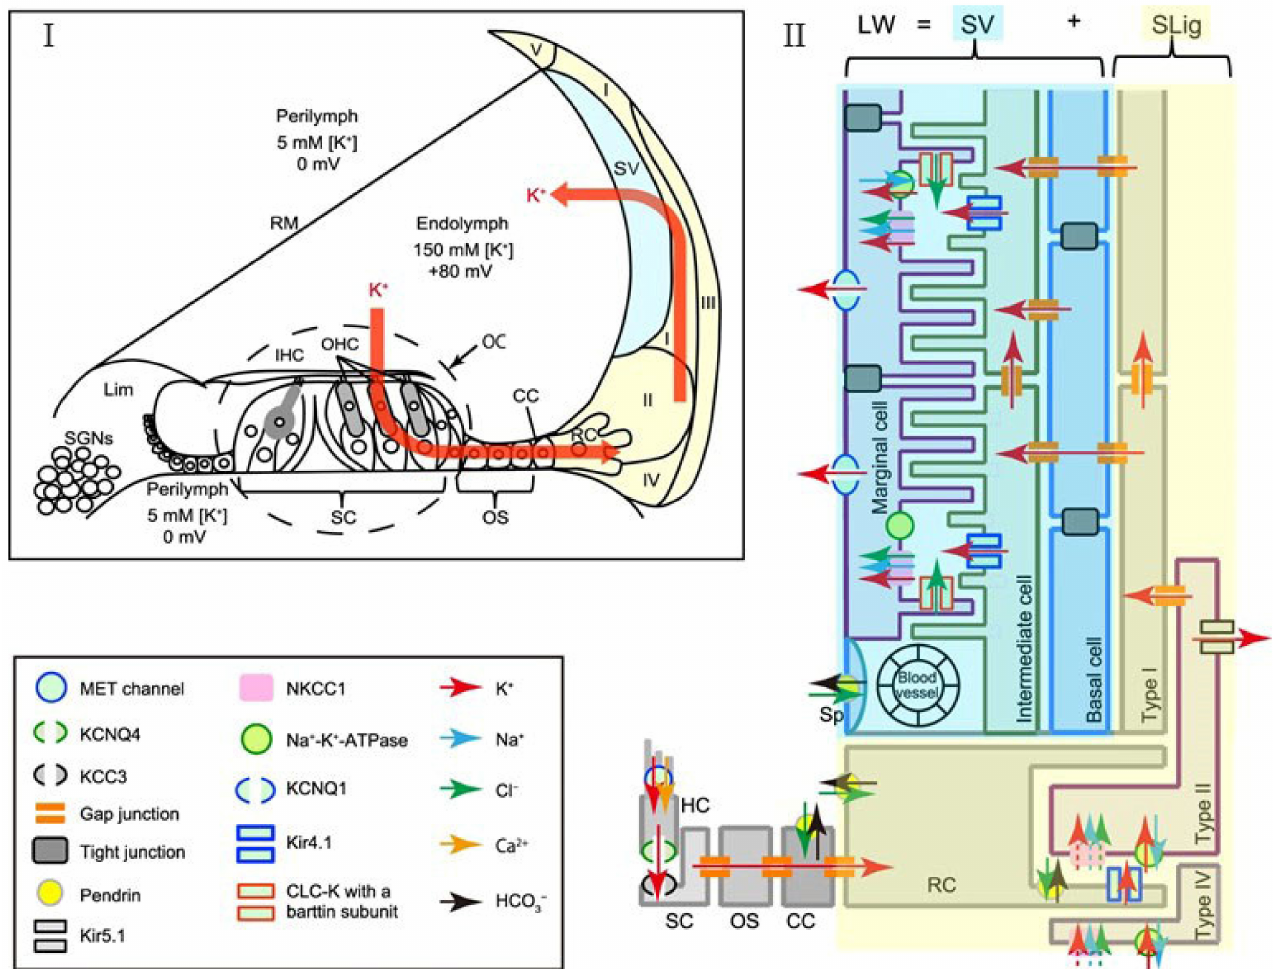
Figure 2. Diagram depicting Na,K-ATPAse, NKCC1 ion transporters, and K + channels involved in ion circulation in the cochlear lateral wall. ( I ) Recirculation of K + between the HCs into the endolymph of the scala media during auditory transduction. The ion channels involved in K + recycling play a vital role in generating the EP and maintaining the lymphatic homeostasis needed for normal hearing. ( II ) NKCC1, Na,K-ATPase, KCNQ1, KCNQ4, Kir 4.1, Kir 5.1, and KCC3 are some various ion transporter channels that play a role in K + circulation and endocochlear potential generation in the SV. HC: hair cells; IHC: inner hair cells; OHC: outer hair cells; OC: organ of Corti; SC: supporting cells; OS: outer sulcus cells; CC: Claudius cells; RC: root cells; Lim: spiral limbus; RM: Reissner’s membrane; SLig: spiral ligament; Sp: spindle cell. From Watabe et al. [108] (Figure 1), with permission from the